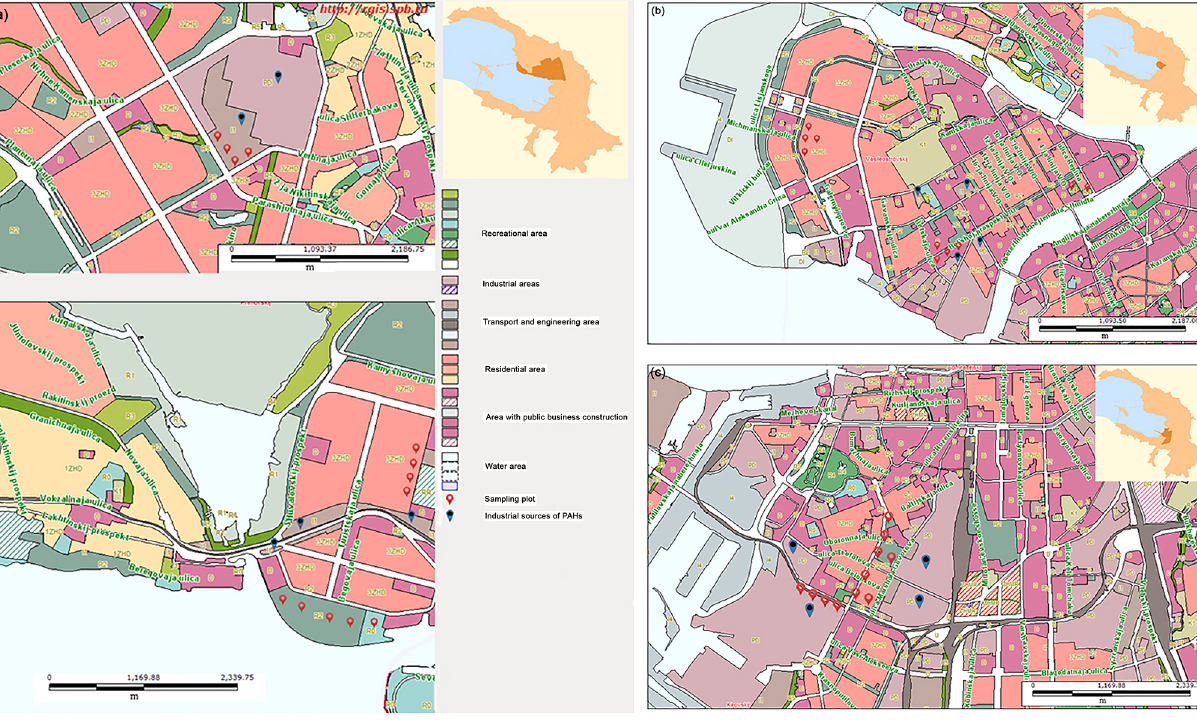
Figure 1. Location of the sampling